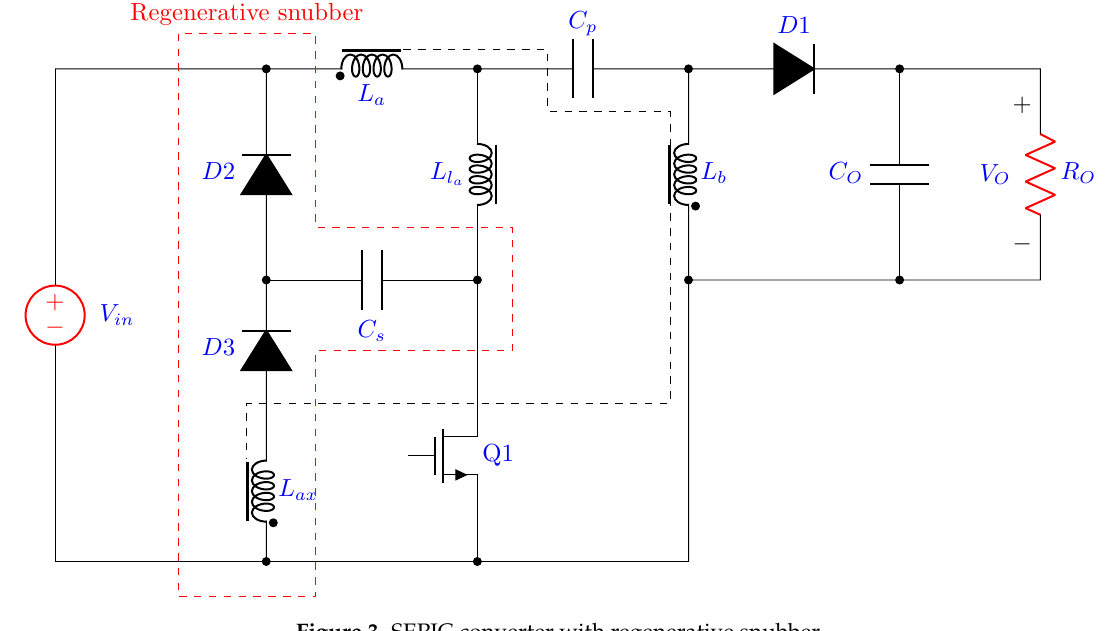
Figure 3. SEPIC converter with regenerative snubber.